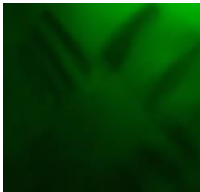
Figure 4. Sample image.